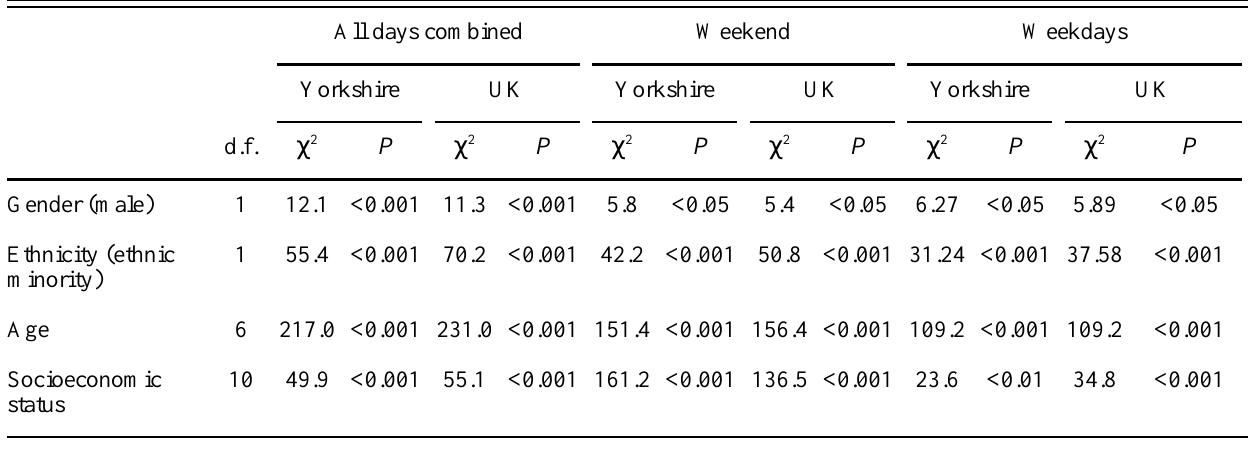
Table 2 . Chi square tests on the sample population vs. the populations of Yorkshire and of the UK. Data for all the sites were analyzed for all days combined, for weekends, and for weekdays. One-way tests were performed for ethnicity and gender. All days combined Weekend Weekdays